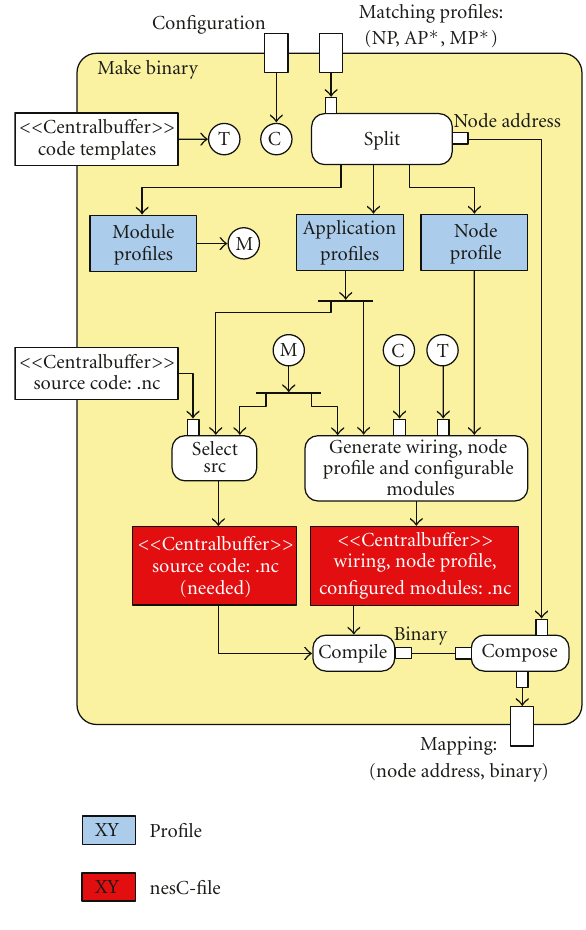
Figure 7: Activity diagram of the make binary action.